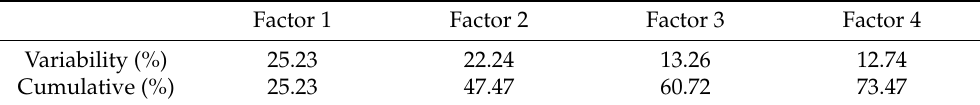
Table 9. Percentage of variance and cumulative variance after varimax rotation (low–low). Factor 1 Factor 2 Factor